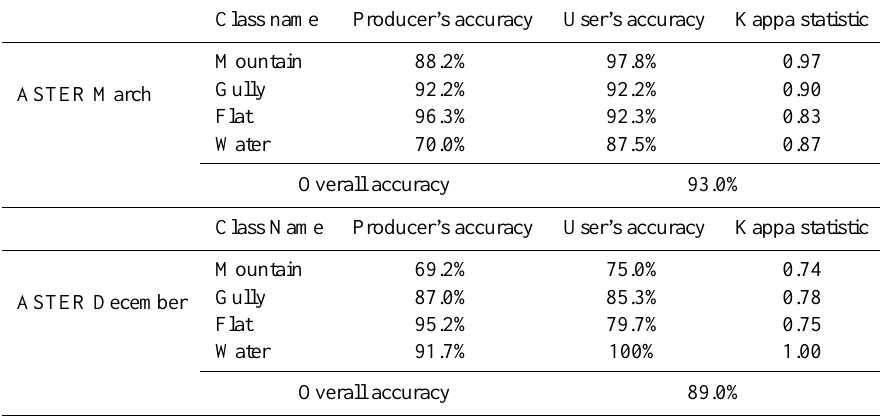
Table 4. Validation of ASTER classification: accuracy statistics report indicating the outcome of the accuracy assessment of the used supervised maximum likelihood classifier.